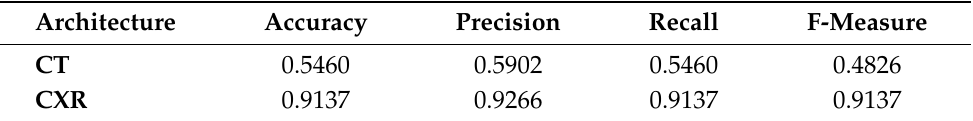
Table 8. Numerical results obtained by using the target histogram evaluated as in Figure 5. The results have been obtained by using the cosine distance, N T = 500 reference images, and a number N bin = 50 of histogram